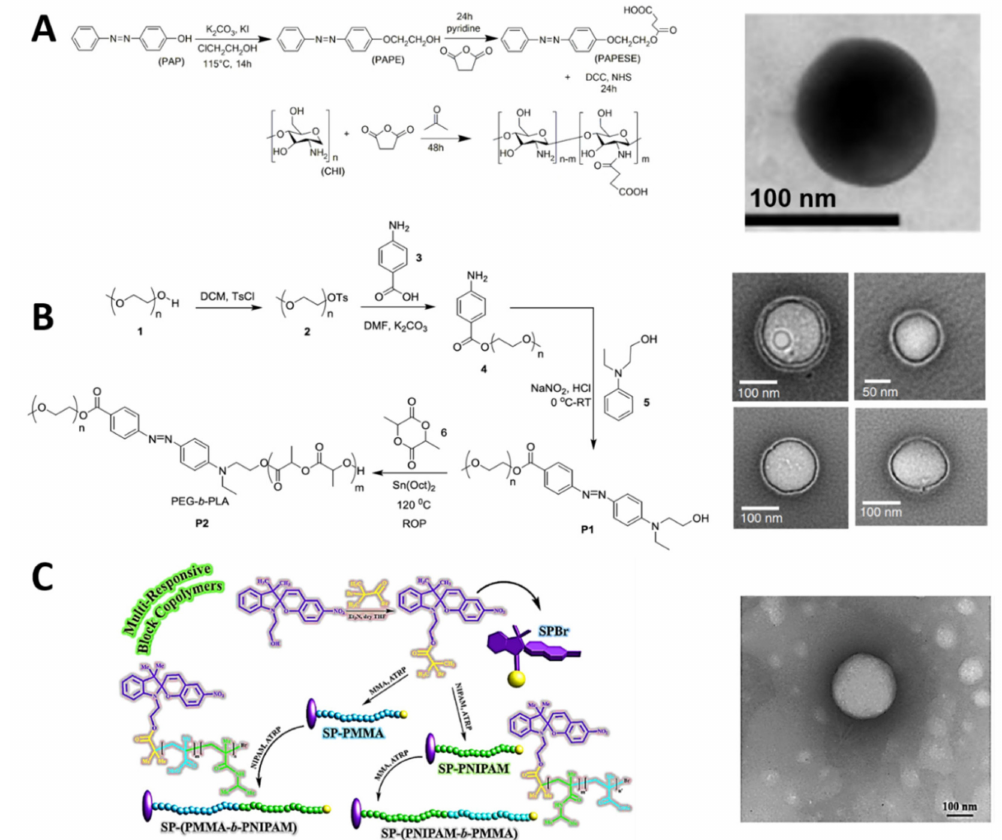
Figure 3. Schematic synthetic route ( left ) and TEM images ( right ) of the corresponding UV photoiso- merizable polymers and nanocarriers. ( A ) PNSC-copolymer, reprinted with permission from [146], copyright 2020, Springer Nature; ( B ) azobenzene PEG-b-PLA-copolymer, reprinted with permission from [147], copyright 2018, Springer Nature; and ( C ) SP-(PMMA-b-PNIPAM)-copolymer, reprinted with permission from [148], copyright 2021,